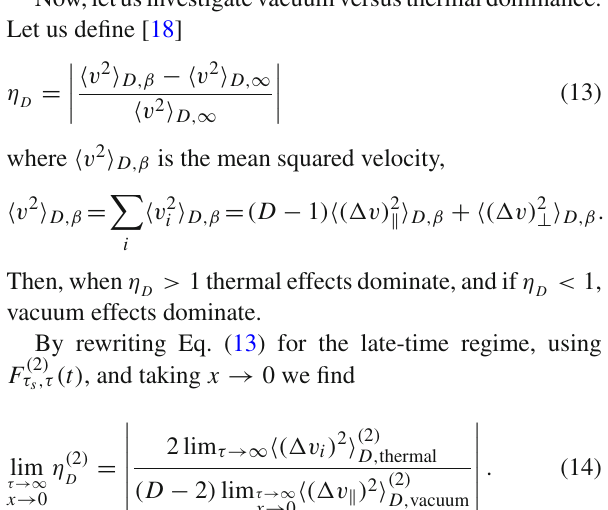
Fig. 8 Distance behavior of the vacuum versus thermal dominance for different values of m β , here D = 3 and τ s /β = 1. When m β = 0 . 6 thermal effects always dominate. Then, as mass is increased, vacuum effects dominate in certain